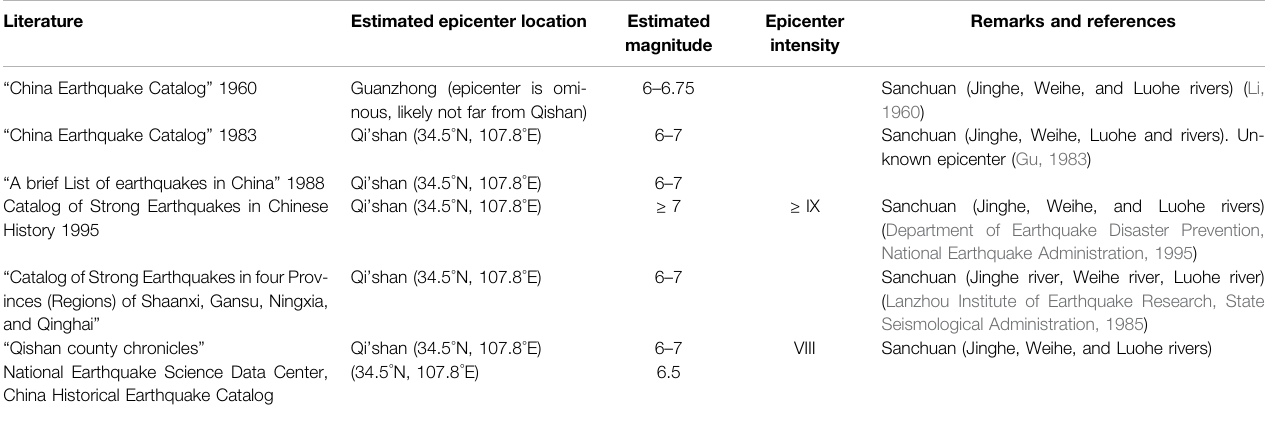
TABLE 1 | Records of the 780 BC Qishan earthquake from different